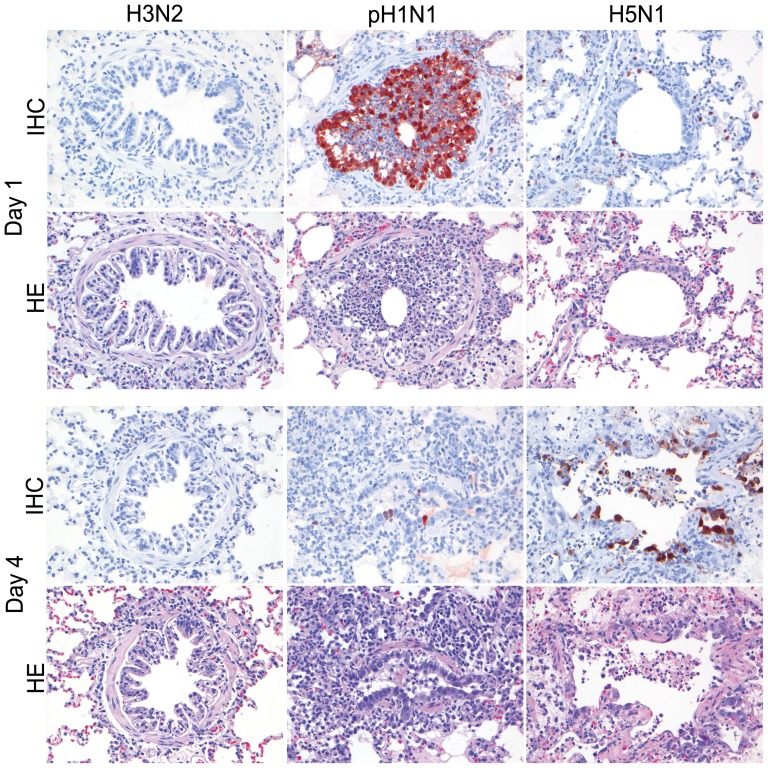
Antigen expression and histopathology of bronchiolar epithelium of ferrets inoculated with different influenza viruses.There is high antigen expression with associated lesions characterized by bronchiolitis in bronchiolar epithelium of ferrets inoculated with pH1N1 on 1 dpi that was low on 4 dpi, consistent with severe loss of bronchiolar epithelium, and for H5N1 there was no expression on 1 dpi and moderate antigen expression with associated lesions on 4 dpi. There were no antigen expression and no lesions for H3N2. HE and immunoperoxidase counterstained with hematoxylin, 200×.